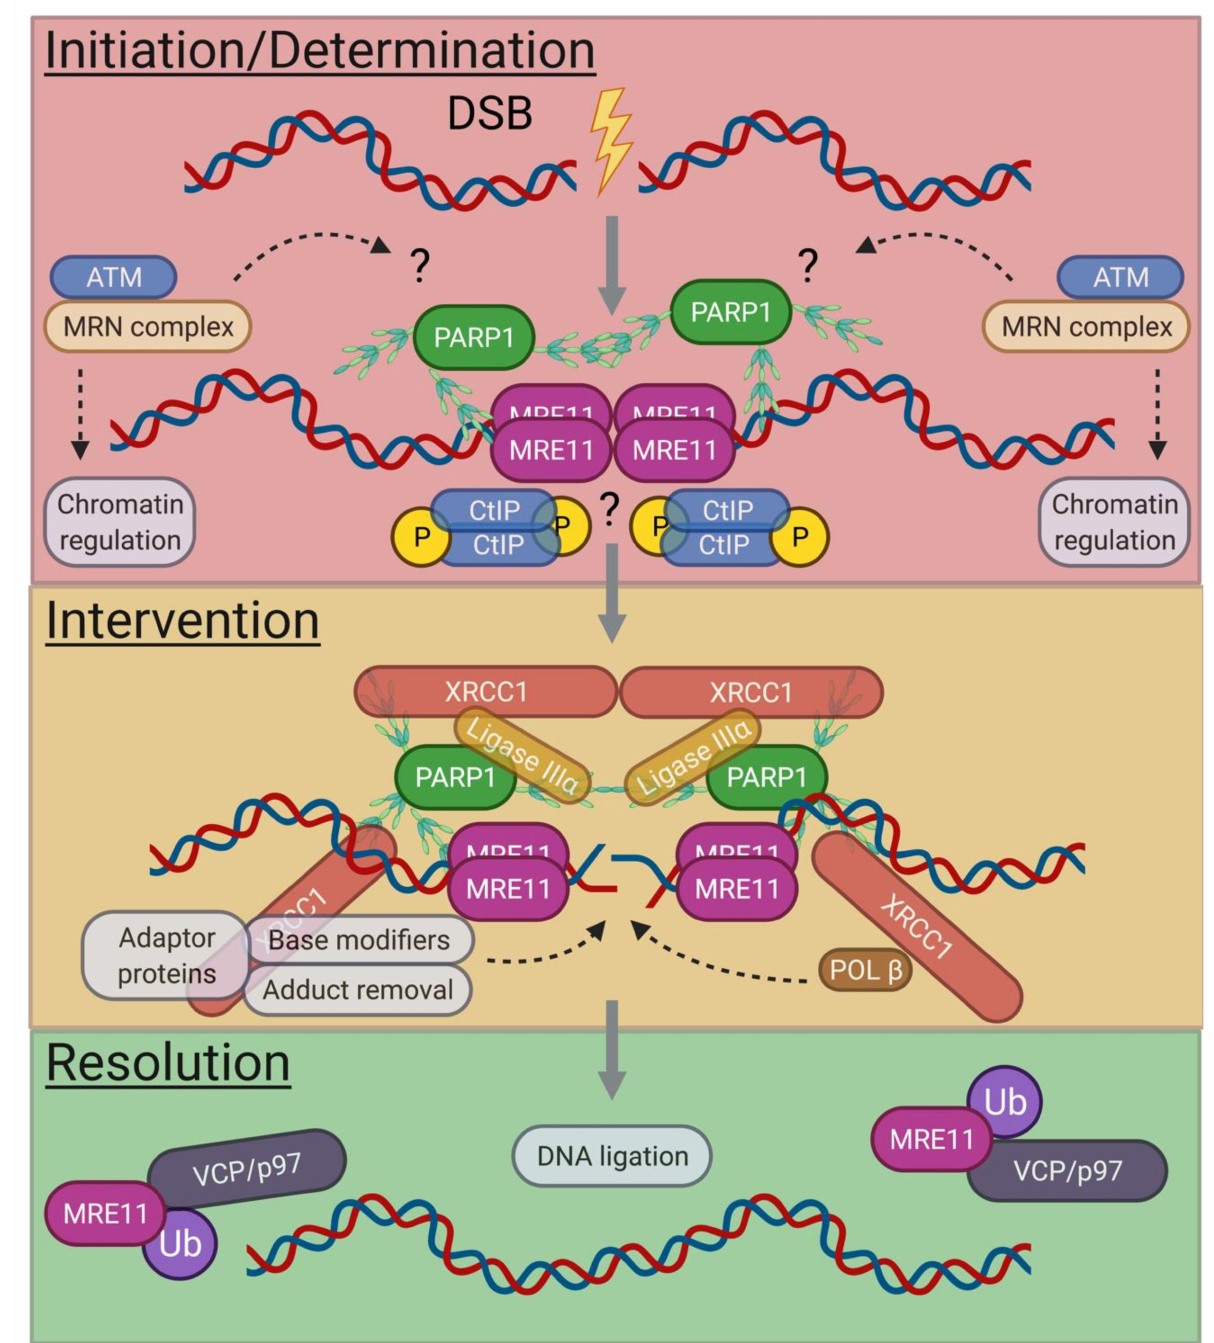
Figure 3. A speculative model for DSB repair by A-EJ in G0-phase cells. Quiescent B cell progenitors do not express POL θ and DNA Ligase I and instead use short-patch BER machinery (PARP1, XRCC1, Ligase III α , POL β , etc.) to complement MRE11 and other MRN-related DDR and tethering functions. Other factors (e.g., TREX1 and CTIP) may support A-EJ and require further investigation. After DNA ligation, MRE11 is ubiquitinated [157], allowing for removal of MRE11 and associated complexes from DNA and dissolution of DNA damage